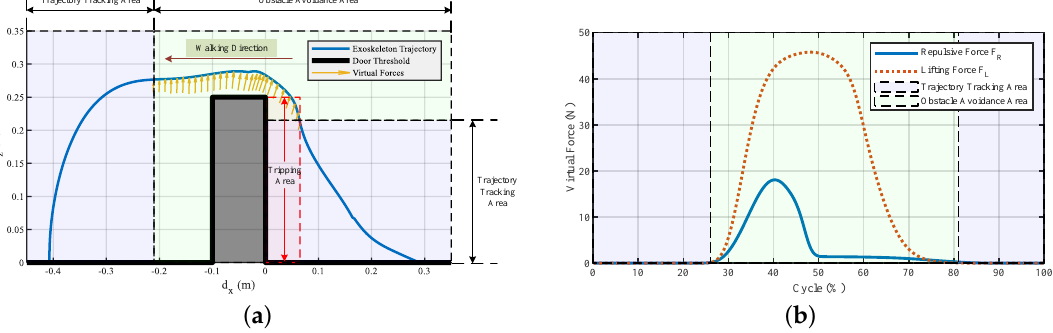
Figure 8. Trajectory and virtual forces of the exoskeleton to step over a door threshold. ( a ) Trajectory of the exoskeleton, the arrows denote the generated resultant force of repulsive and lifting forces. The dotted red rectangle indicates the danger area that would cause tripping if a person could not swing their leg high enough. ( b ) Repulsive and lifting forces generated during stepping over a door threshold. F R is the repulsive force used to help the pilot avoid kicking the door threshold, F L is the force used to help the pilot lift their leg. The repulsive force and the lifting force worked in the green